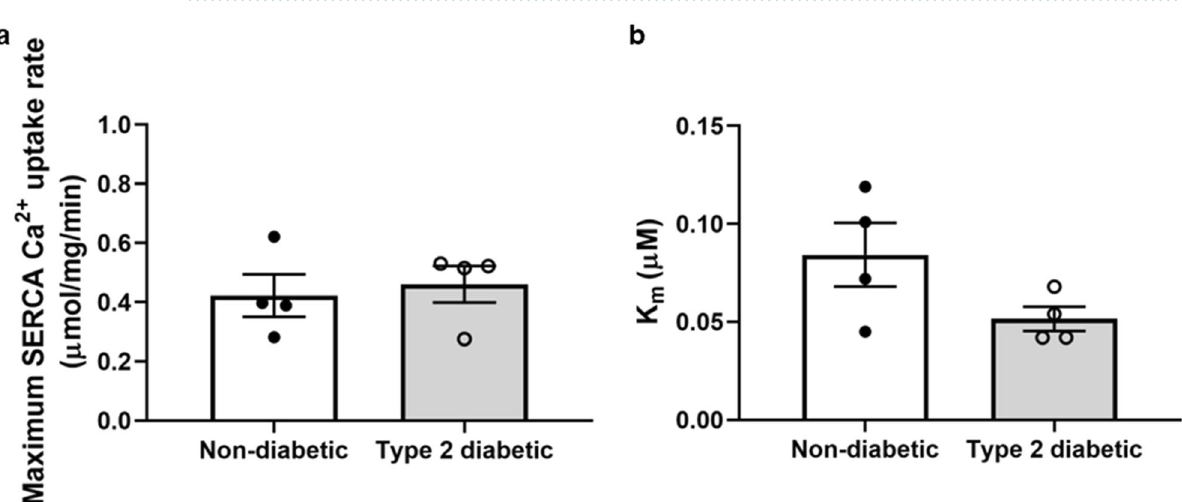
Figure 5. SERCA activity in non-diabetic and diabetic rat myocardium. ( a ) The maximum SERCA Ca 2+ uptake rate, and ( b ) Michaelis constant (K m ) for the non-diabetic and diabetic rat myocardium. Data shown are means ± SEM, obtained from triplicate readings, P > 0.05 versus non-diabetics, unpaired